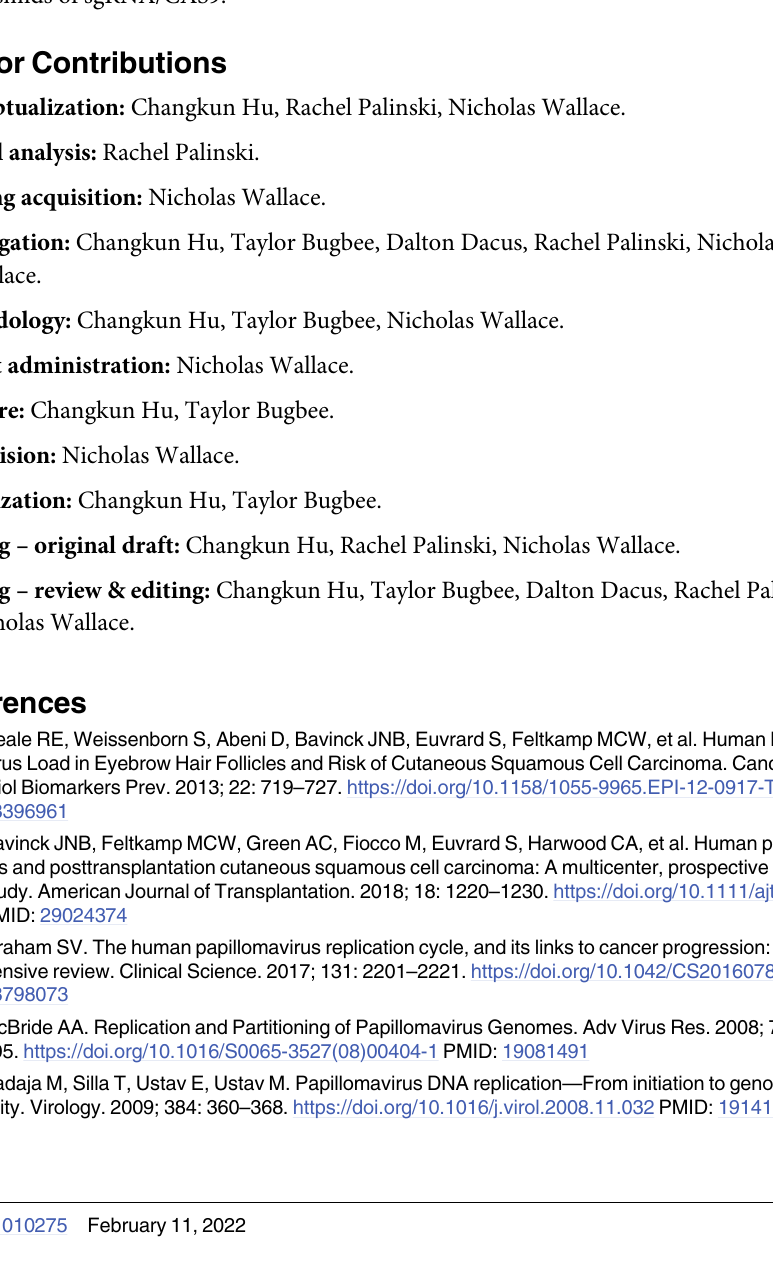
S10 Fig. Controls for NU7441 inhibitor of DNA-PKcs. (TIFF) S11 Fig. RAD51/pDNA-PKcs colocalization occurs at CAS9-induced DSBs in 8E6 express- ing HFKs. S1 Table. List of primers used for next-generation sequencing.